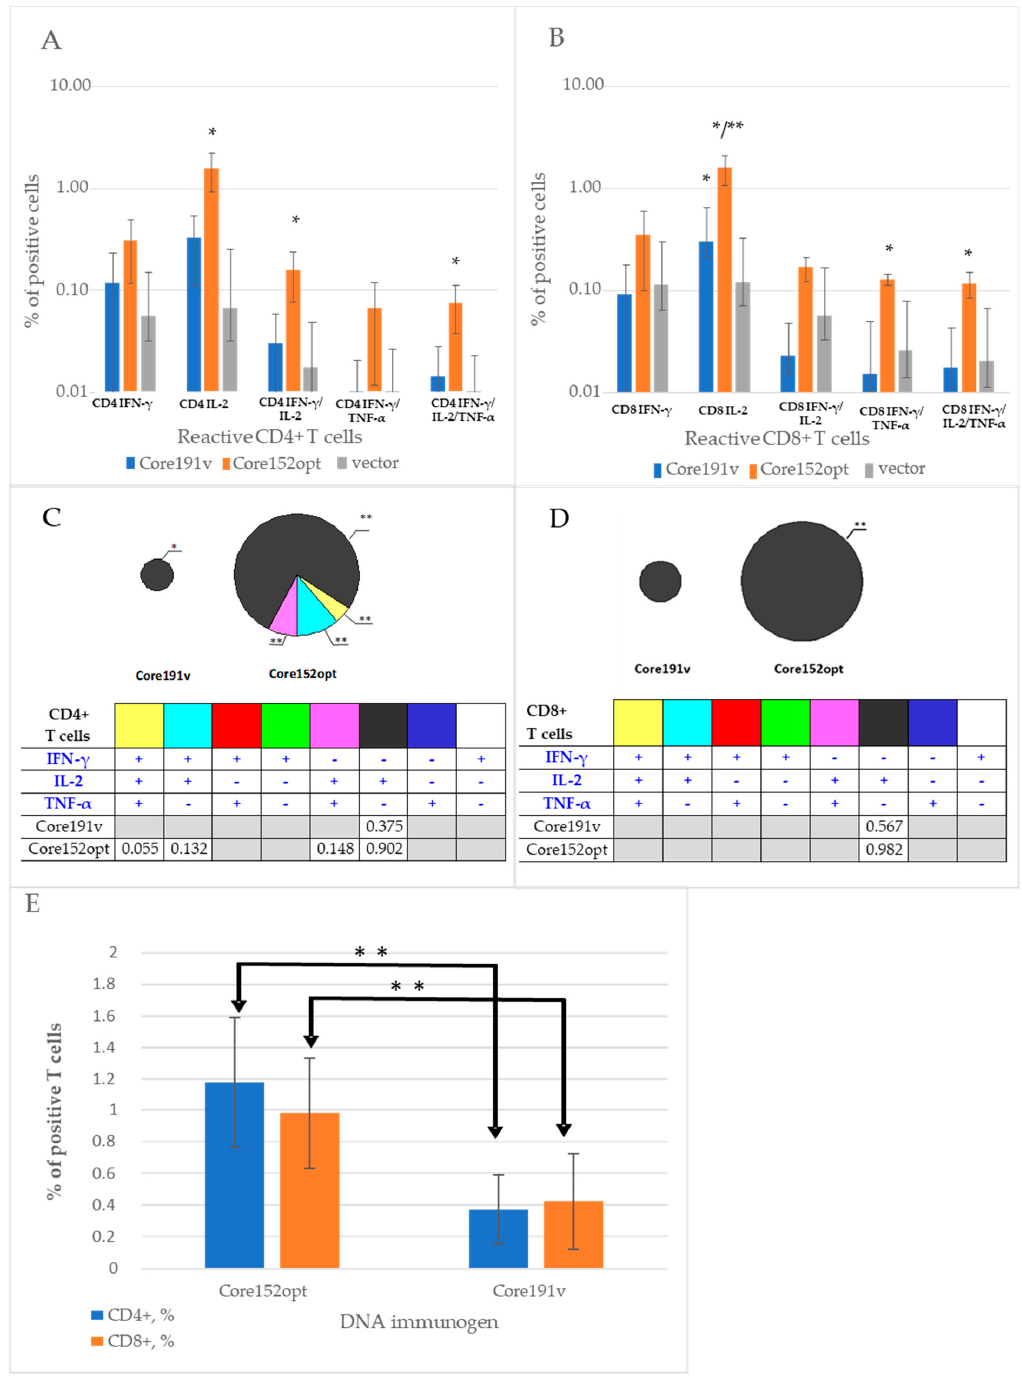
Figure 2. Specific T cell response in mice DNA immunized with Core191v or Core152opt compared to empty vector. CD4+ ( A , C ) and CD8+ ( B , D ) T cell response by inclusive ( A , C ) and exclusive ( B , D ) principles (exclusive visualize populations of cells secreting just the indicated cytokine), and total percent of reactive CD4+ and CD8+ T cells ( E ). Data from immunization series I; for vector mice, combined data from series I and II (Table 1). In panels ( A , B , E ), average per group ± STDV; in panels ( C , D ), average per group. Size of the pies is proportional to the total average % of T cells of a given type in the group. * p < 0.05; and (*) p < 0.1 in mice immunized with HCV core DNA compared to vector immunized animals; ** p < 0.05 in Core152opt versus Core191v immunized mice; pairwise comparisons by Mann-Whitney U -test.